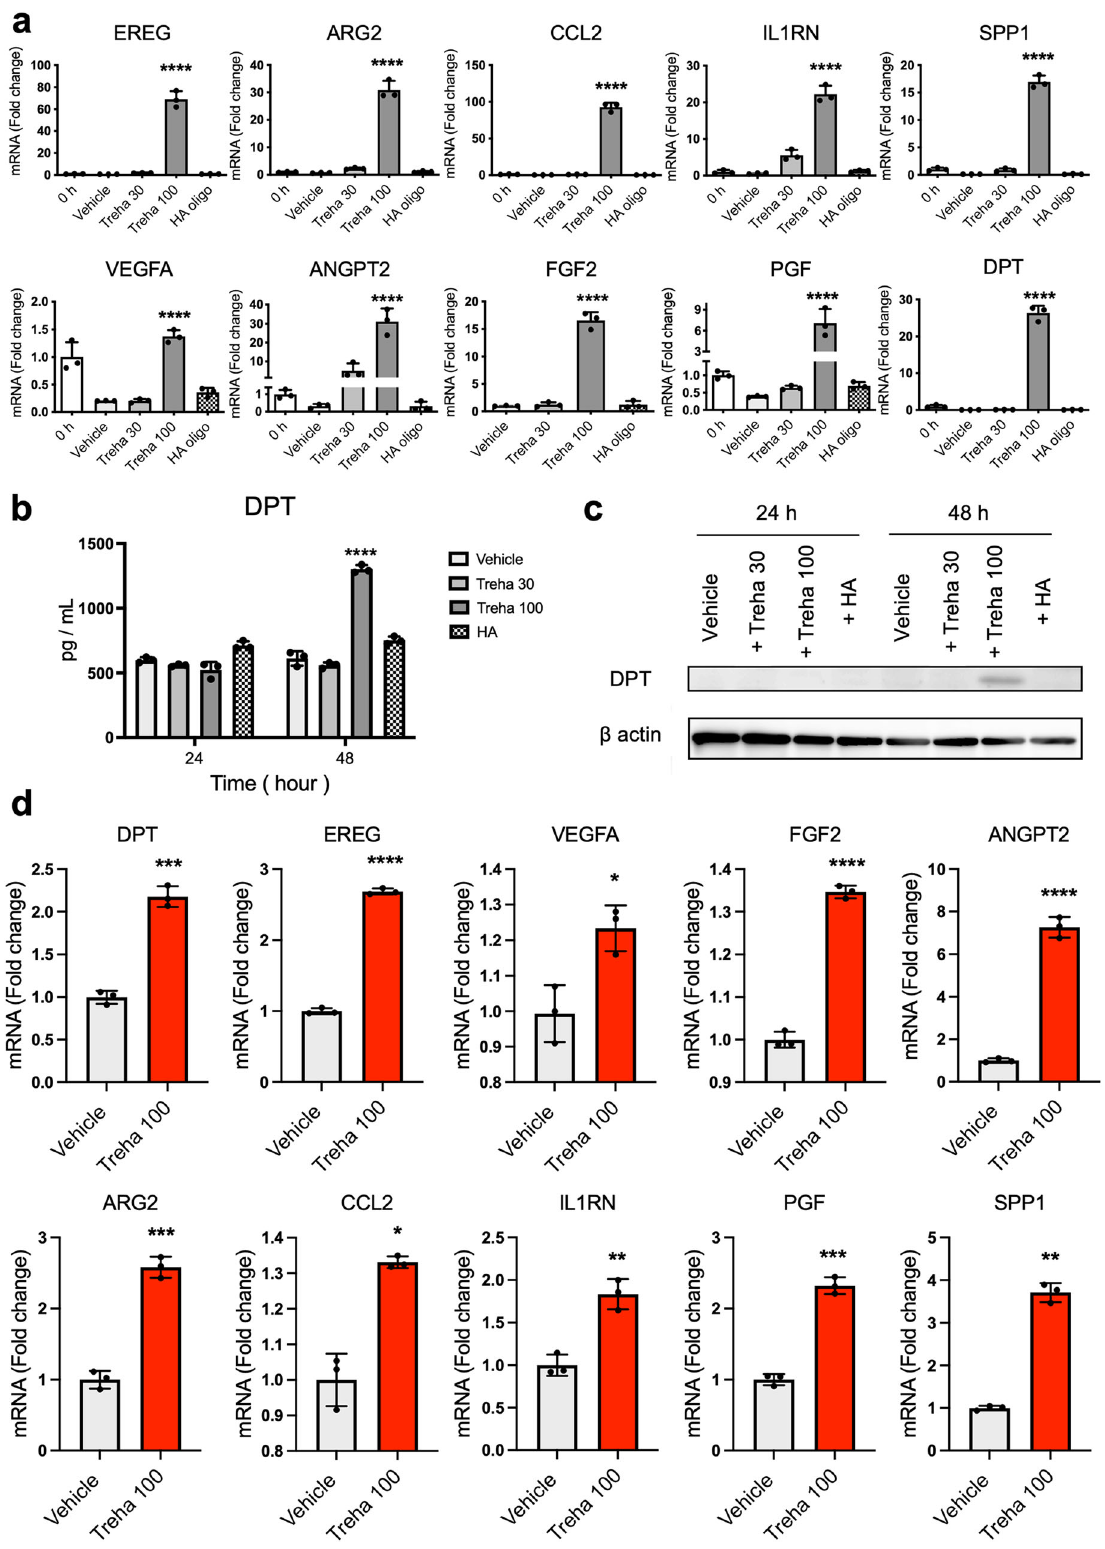
CDKN1A is involved in the facilitated wound healing by the dermal substitute with high-concentration trehalose-treated fi broblasts . Next, we investigated the involvement of CDKN1A in the trehalose-induced promotion of wound healing in vivo. CDKN1A knockdown was con fi rmed by its signi fi cantly suppressed mRNA levels post-siRNA transfection (Supplementary Fig.